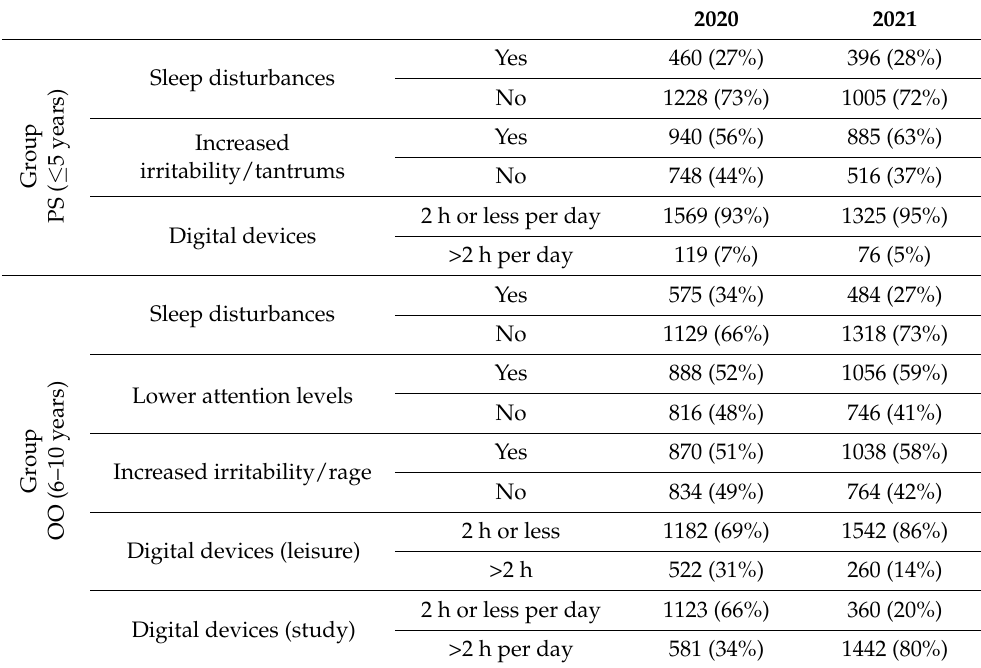
Table 1. Answers about lockdown impact reported by parents, distributed by age